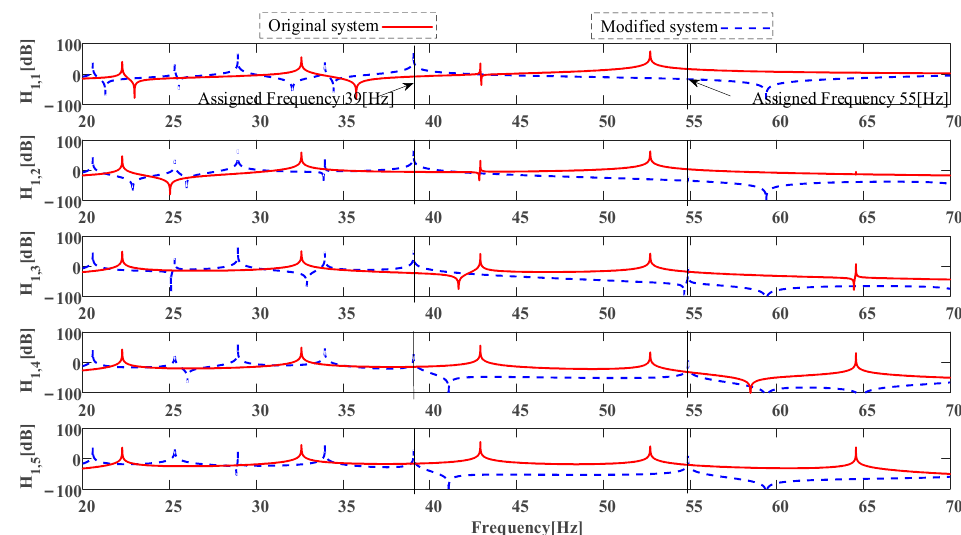
Figure 30. Original FRFs and FRFs after the addition of mass-spring substructures. As with the simultaneous addition of masses and supporting stiffness, the addition Table 22. Comparison of natural frequencies and mode shapes. of spring-mass substructures also demonstrated excellent performances in both mode shapes and frequencies assignment. This was also because more modification variables (five added masses and five added stiffness) were provided in the addition of substruc- tures.